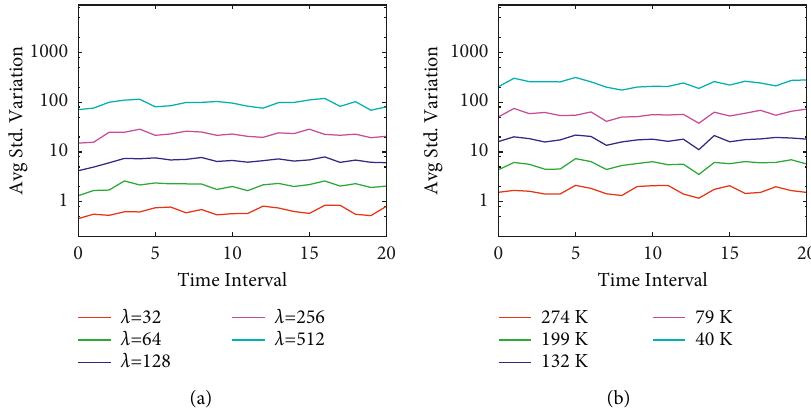
Figure 5: Average standard variations over 20 days. (a) REGION. (b) GRID.